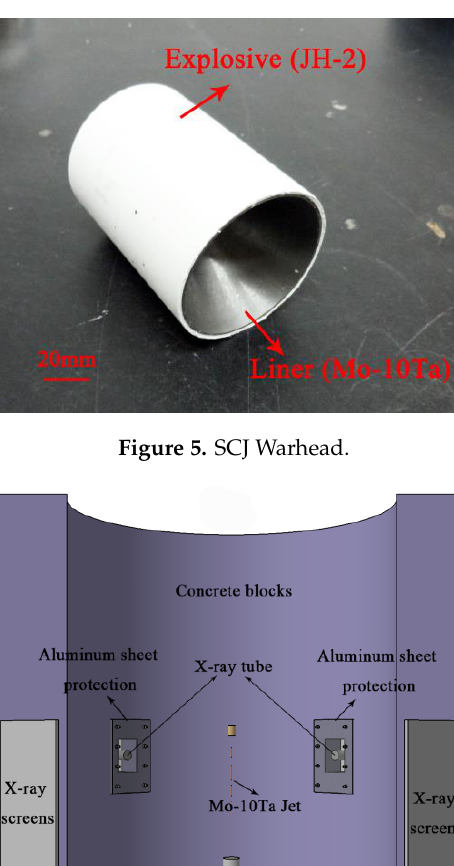
Figure 4. The forming process of SCJ.